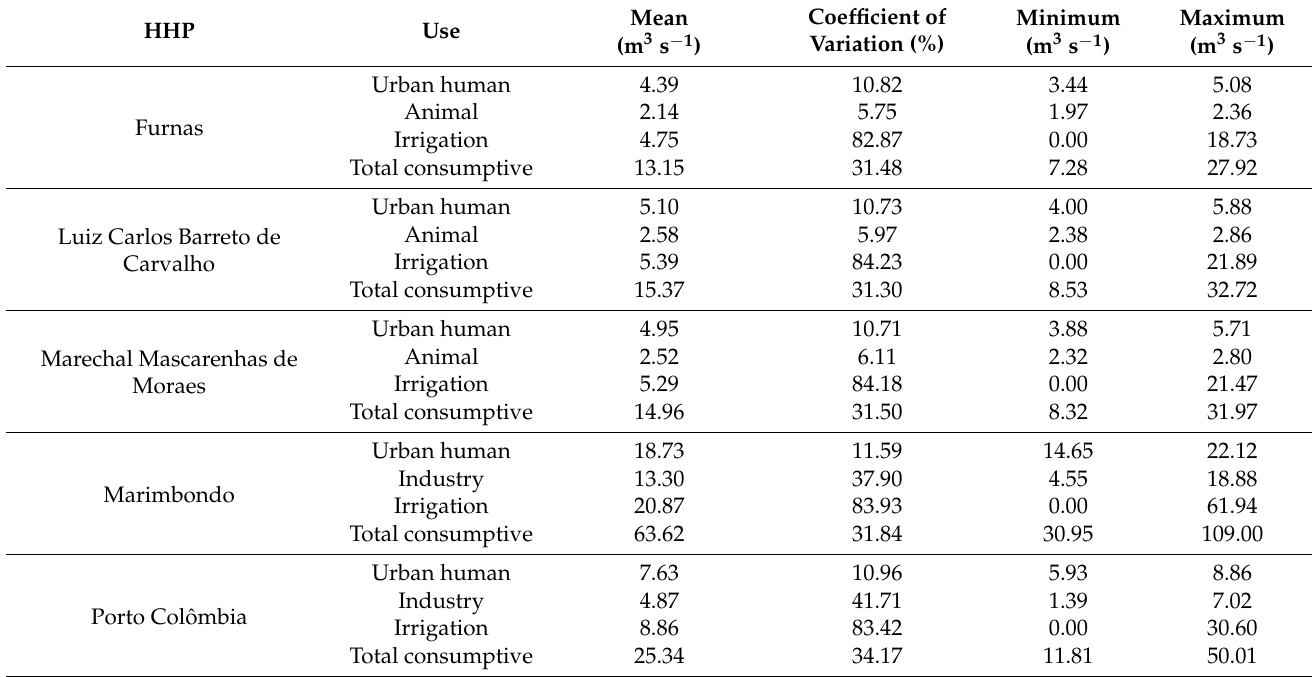
Table 4. General statistics on water uses in the reservoirs of Furnas, Luiz Carlos Barreto de Carvalho, Marechal Mascarenhas de Moraes, Marimbondo and Porto Colombia.